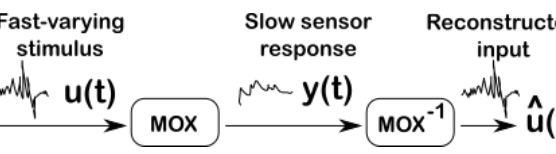
Figure 1. Deconvolution of metal oxide (MOX) gas sensors. The deconvolution operation consists of reconstructing the fast-varying concentration u(t) encountered in turbulent plumes by inverting the low-pass filtering e ff ect of MOX